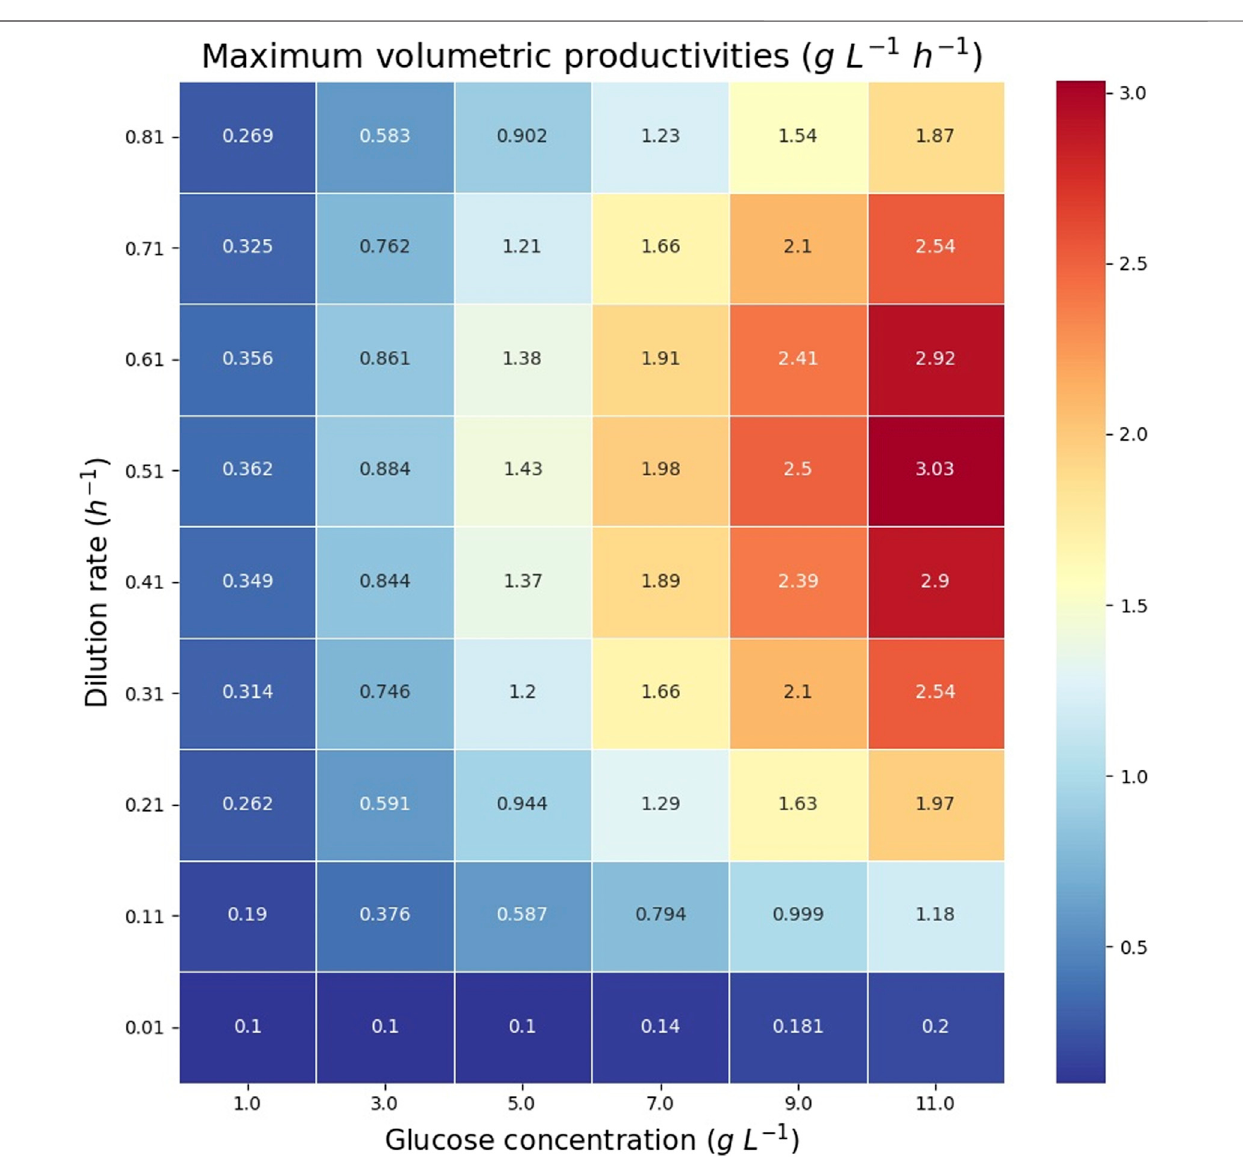
Frontiers in Molecular Biosciences |